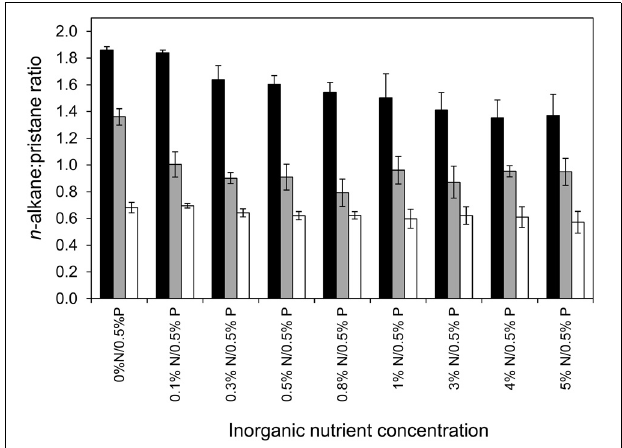
FIGURE 6 | Effect of inorganic N (0–5%) with constant P (0.5%) treatment w/w of oil on the degradation on n-alkane (nC17, nC13, and nC25) to pristane ratios in microcosm comprising 10g beach sediment and 125mg North Sea crude oil. Each data point represents average value of three replicates. nC17:pristane black bars, nC13:pristane gray bars, nC25:pristane white bars.